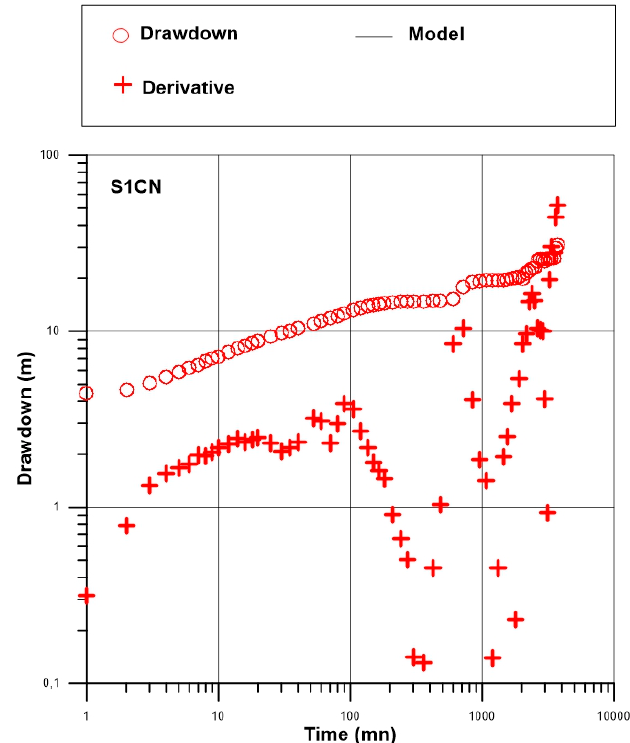
Figure 7. Observed drawdown and its derivative in pumping well S1CN.